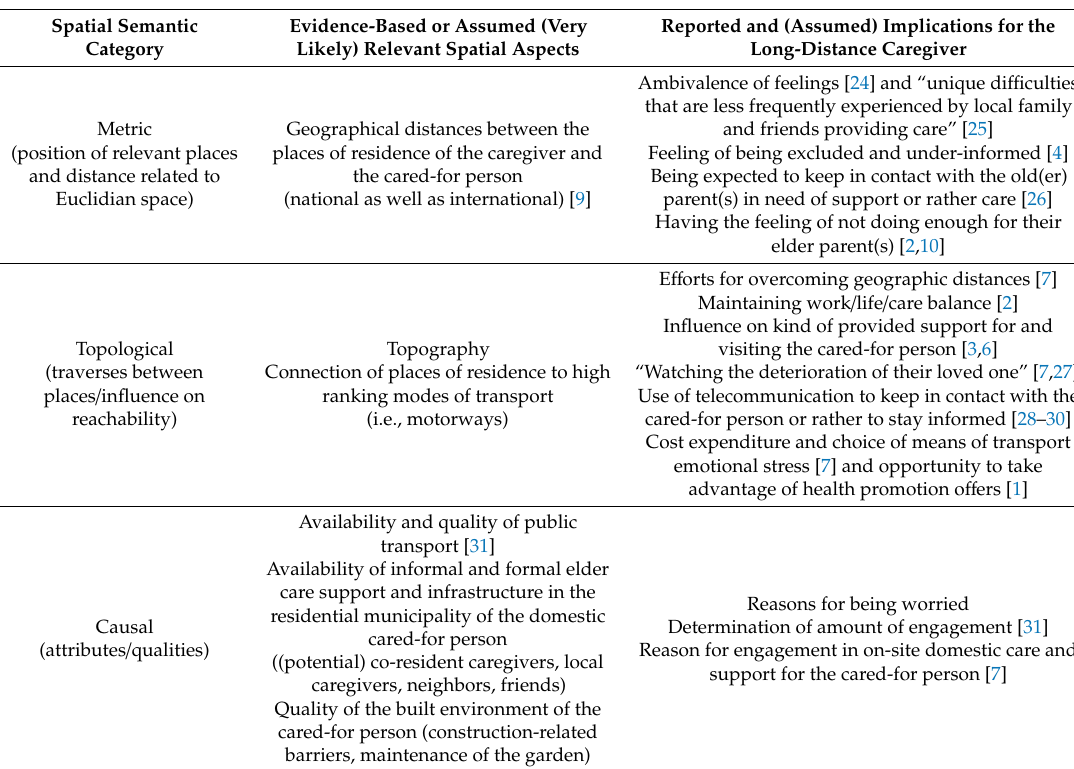
Table 1. Considering the space–care nexus applying spatial semantics taking the viewpoint of the long-distance caregiver based on (empirical findings in) international literature and own assumptions. Own